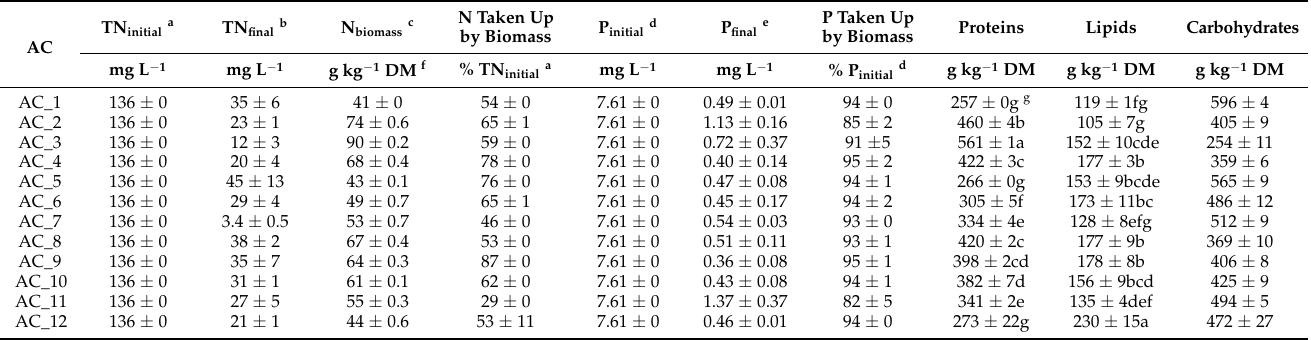
Table 3. Nitrogen and phosphorus mass balance and biochemical